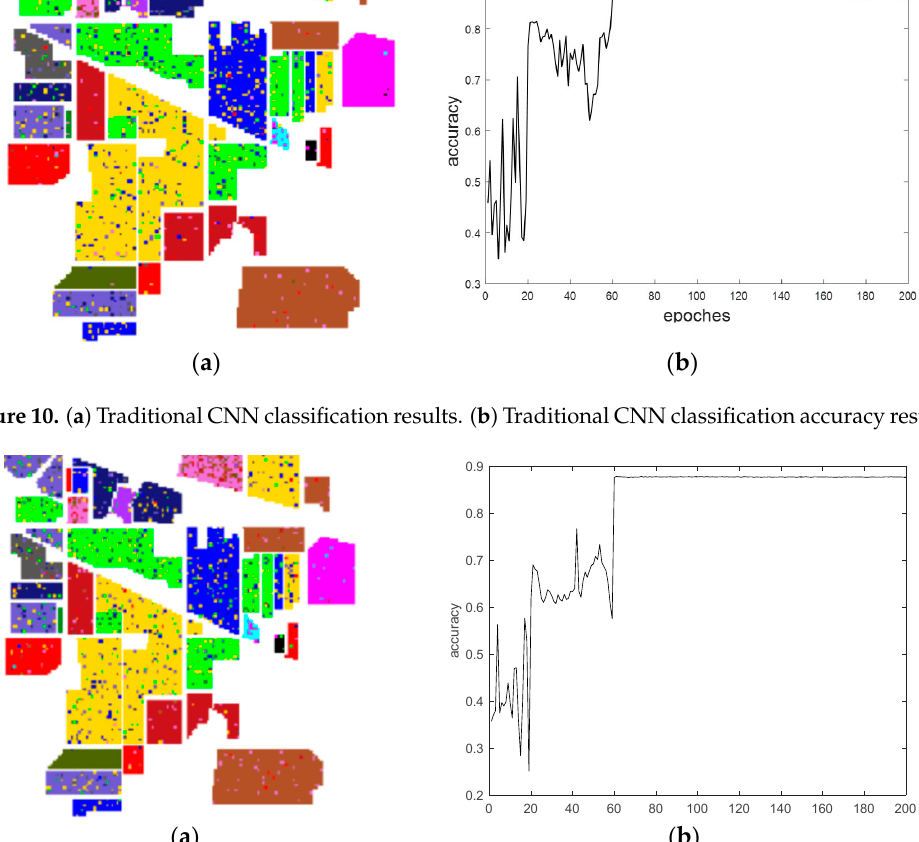
Figure 11. ( a ) Maximum overlapping pooling CNN classification results. ( b ) Maximum overlapping pooling CNN classification accuracy results.